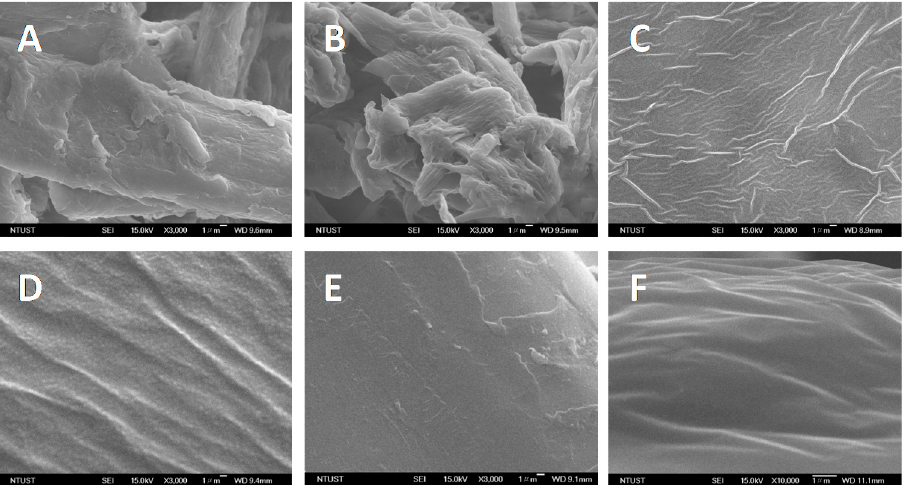
Figure 5. Surface and cross-sectional morphologies of cellulose films; ( A ) MCC; ( B ) CA-5; ( C ) CQA- 5;( D ) CTA-5; ( E ) CNA-5; and ( F ) Cross-section CNA-5.